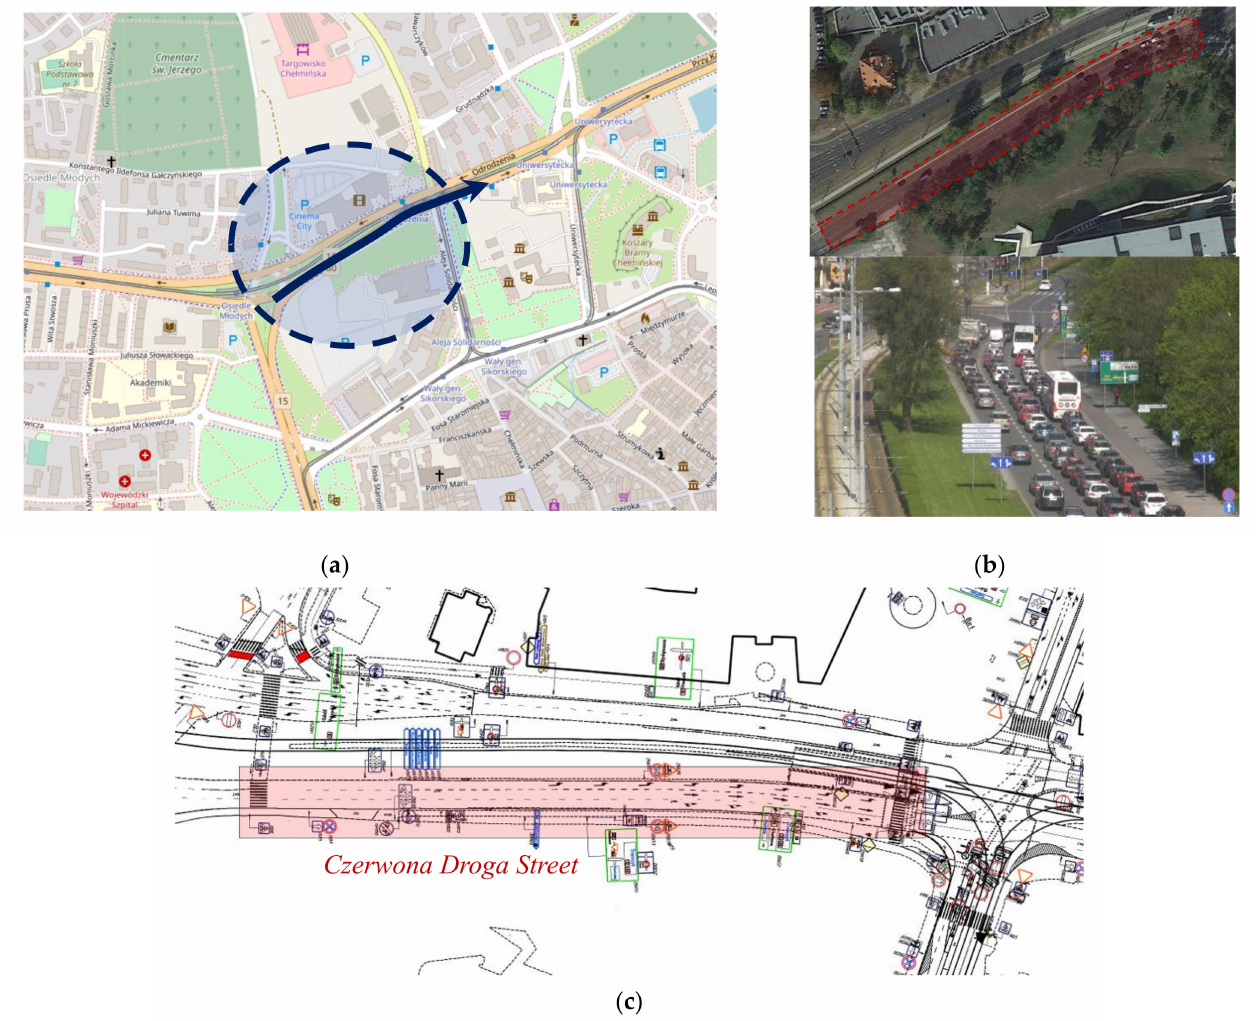
Figure 2. An example of a measuring section adopted as a model for research (Poland, Torun city, intersection approach Czerwona Droga Street/west/): ( a ). measuring section location; ( b ). view of the queue of the vehicle on a measuring section; ( c ). situational plan. Source: Own work based on Open Street map, Google Earth and WZDR System